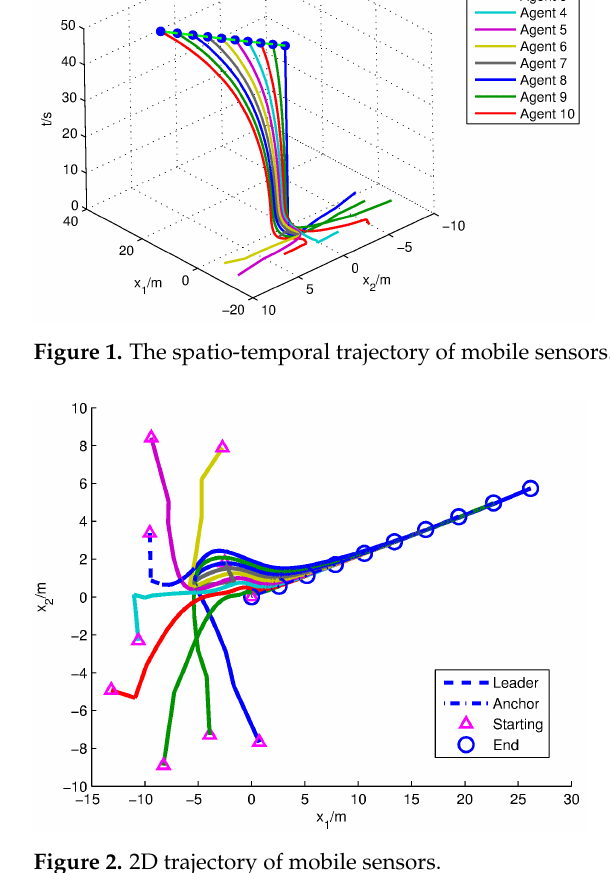
Figure 2. 2D trajectory of mobile